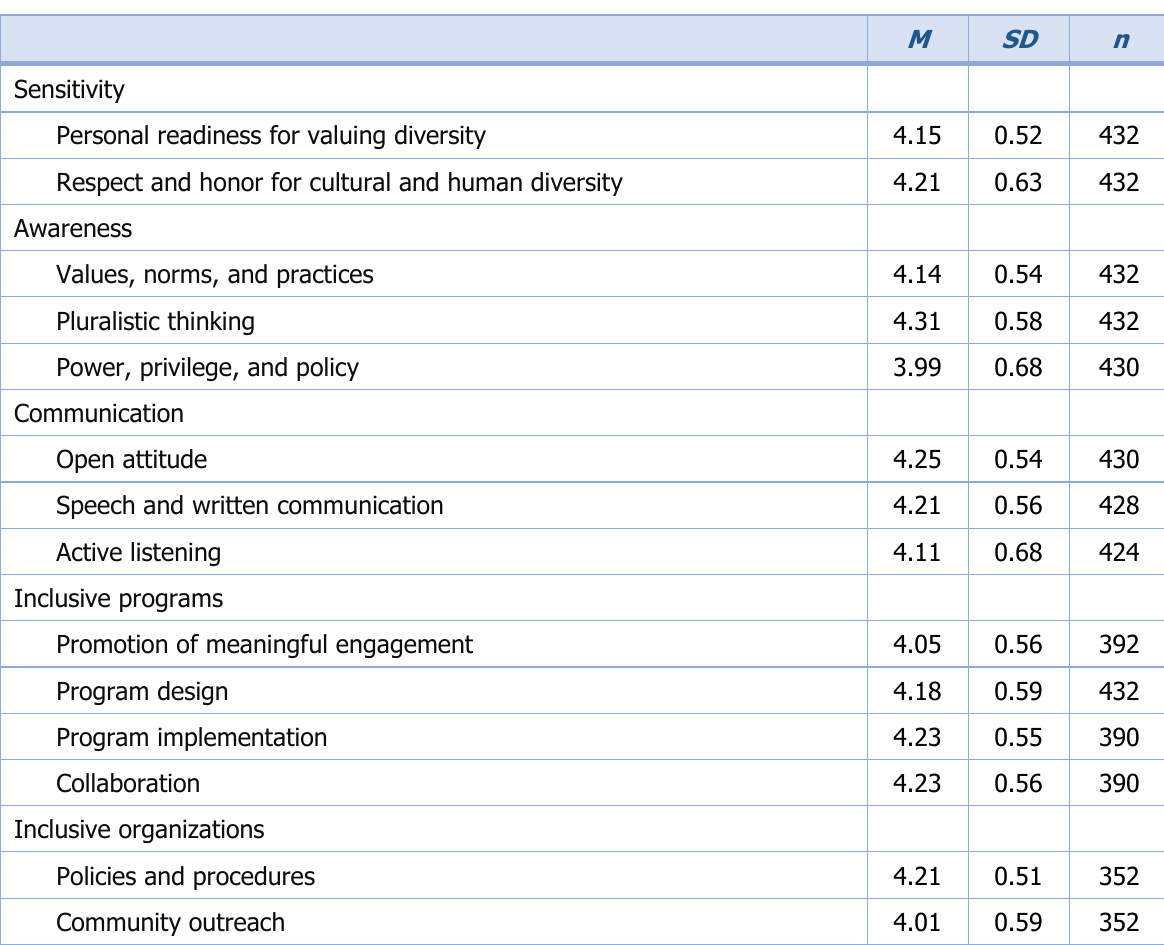
Table 4. Index Means and Standard Deviations of 4- H Extension Agents’ Perceived Importance of the AEO Domain